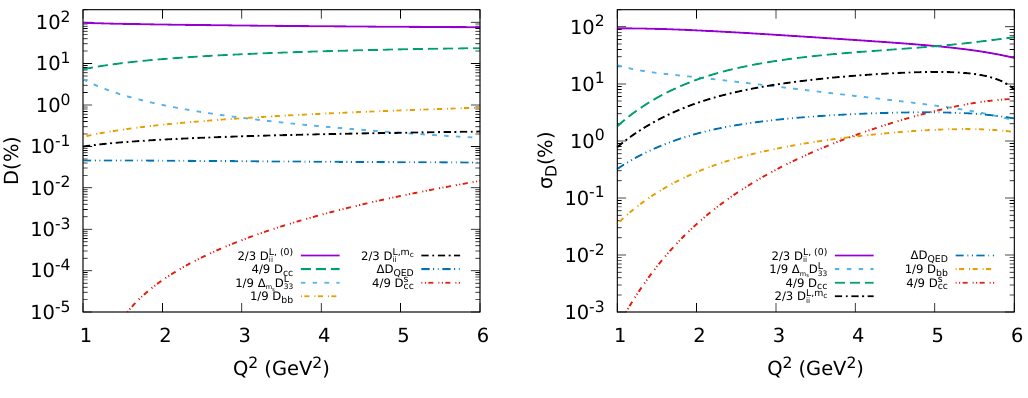
Figure 11 . Relative contribution to the value (left) and the uncertainty (right) of D ( Q 2 ) as a function of Q 2 taking as input α ( n f =5) s ( M 2